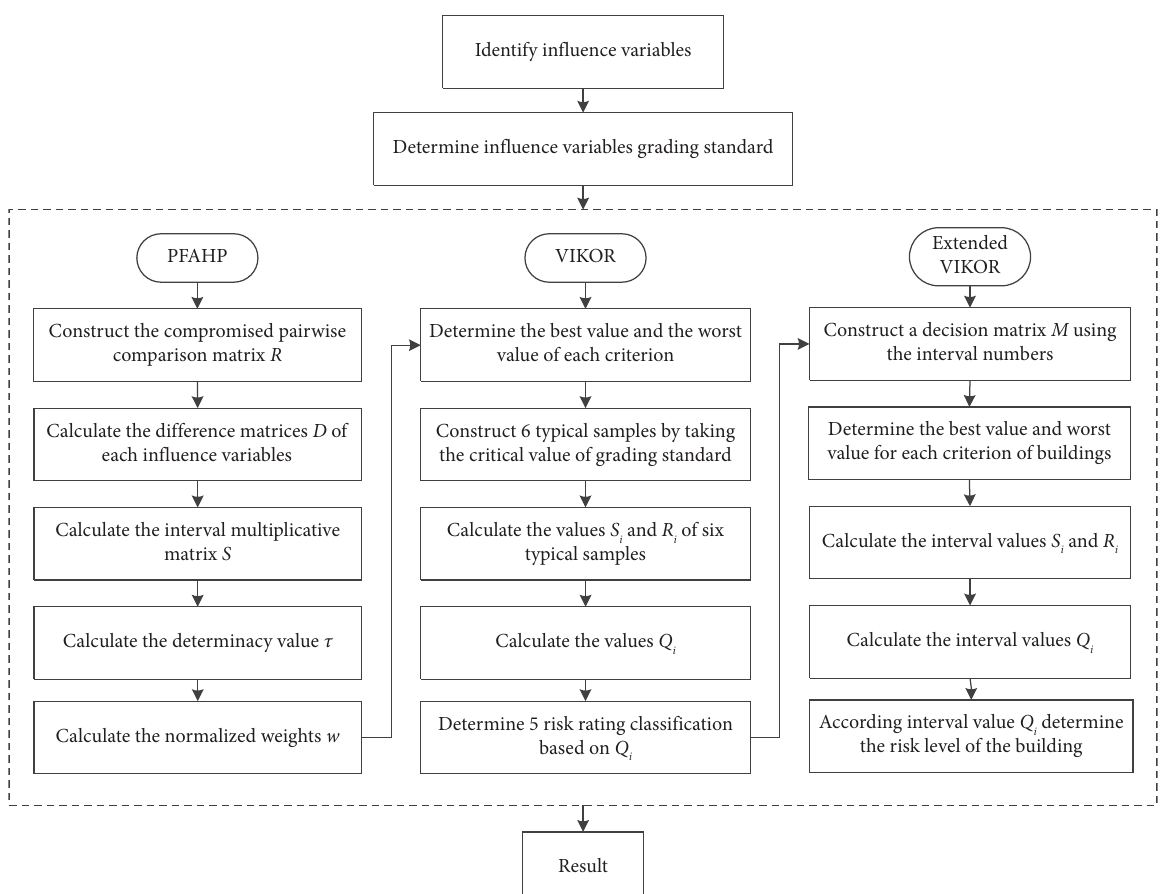
Figure 1: Flowchart of risk assessment of adjacent buildings in shield tunneling